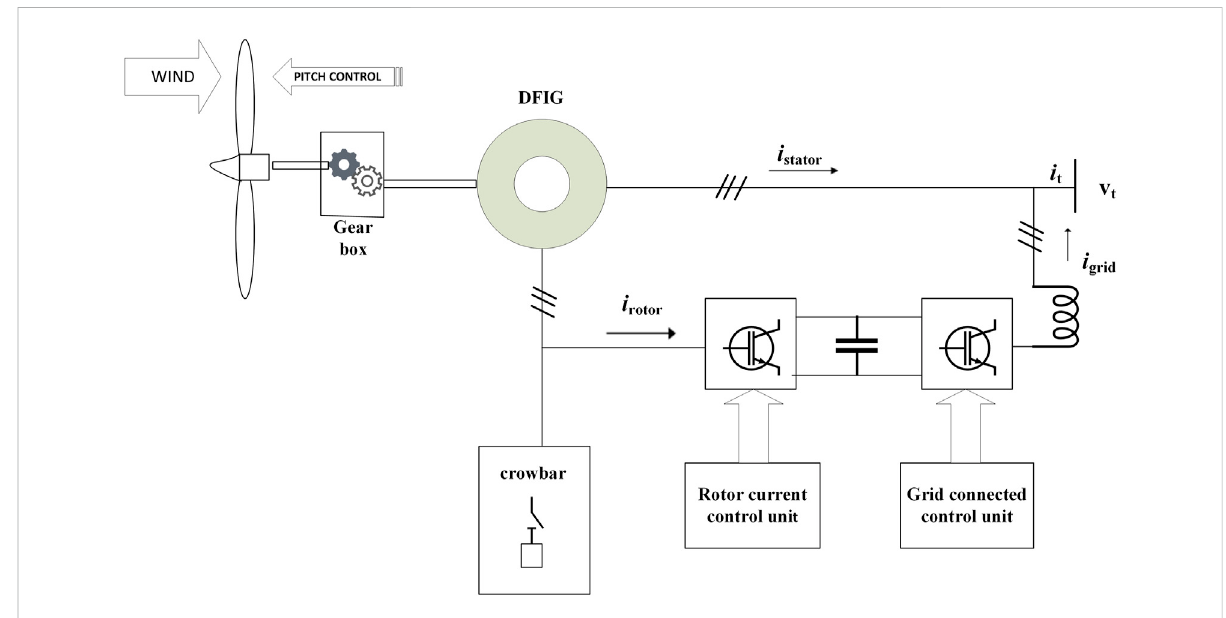
FIGURE 2 Transient stability control of the DFIG wind